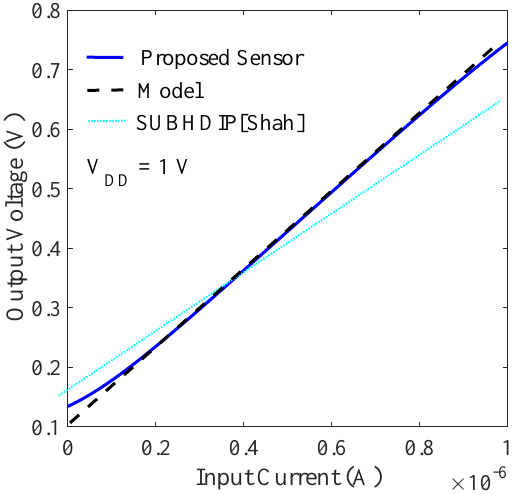
Figure 9. Comparative analysis ot transfer characteristics for the proposed